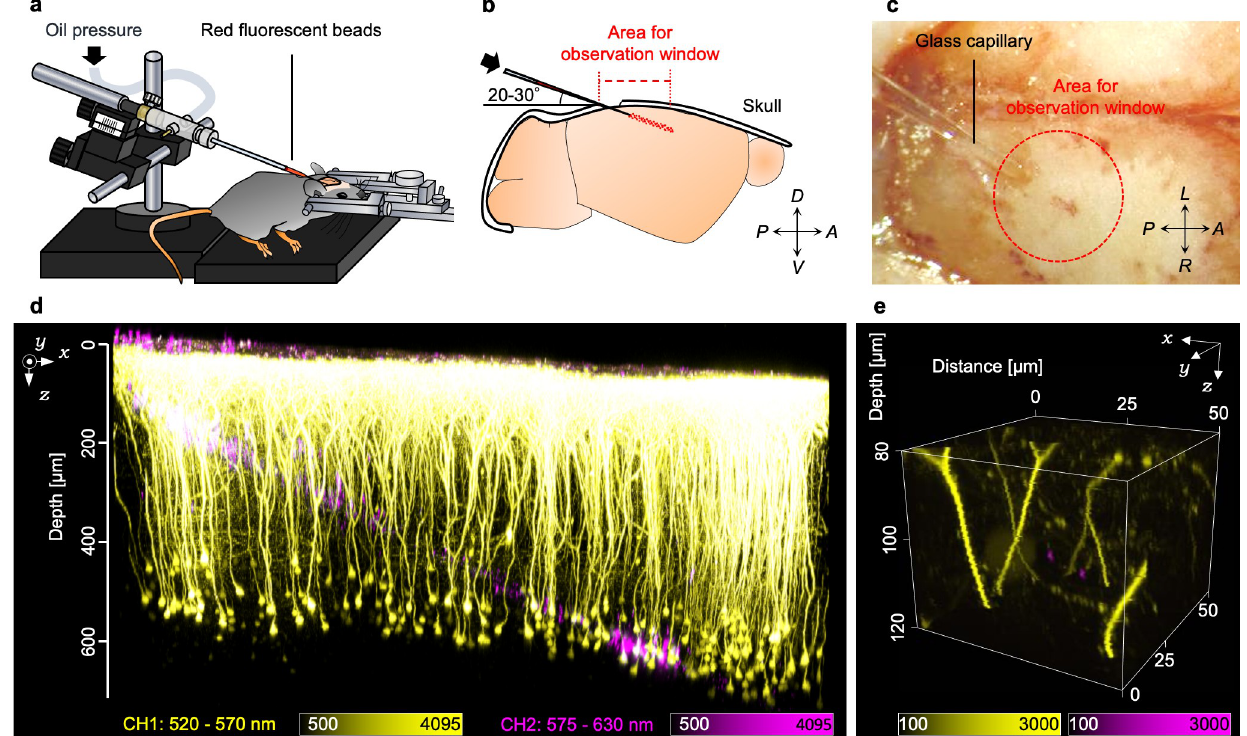
Fig 1. Injection of fluorescent beads into living mouse brains. (a) Schematic illustration of the injection method. The fluorescent red beads were injected into the living mouse brain by oil pressure through the glass capillary. (b) Schematic illustration of the injection strategy. The glass capillary was inserted into the brain at shallow angles of 20˚–30˚ to the brain stereotaxic apparatus. (c) A bright-field image of the skull during the injection. (d) A 3D reconstructed image of the neurons (yellow) and the injected red fluorescent beads (magenta). (e) An example of the 3D reconstructed image of the area containing two single fluorescent beads within the living mouse brain. A: anterior, P: posterior, D: dorsal, V: ventral, R: right, and L: left.